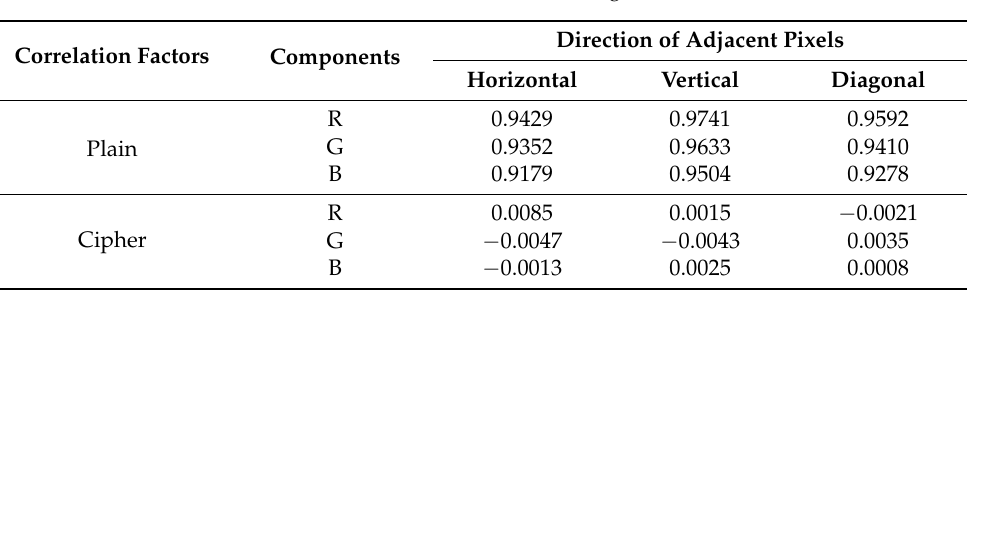
Figure 6. Correlation distribution: ( a , d ) Horizontal distribution in the red channel of the plain and cipher images; ( b , e ) Vertical distribution in the green channel of the plain and cipher images; ( c , f ) Diagonal distribution in the blue channel of